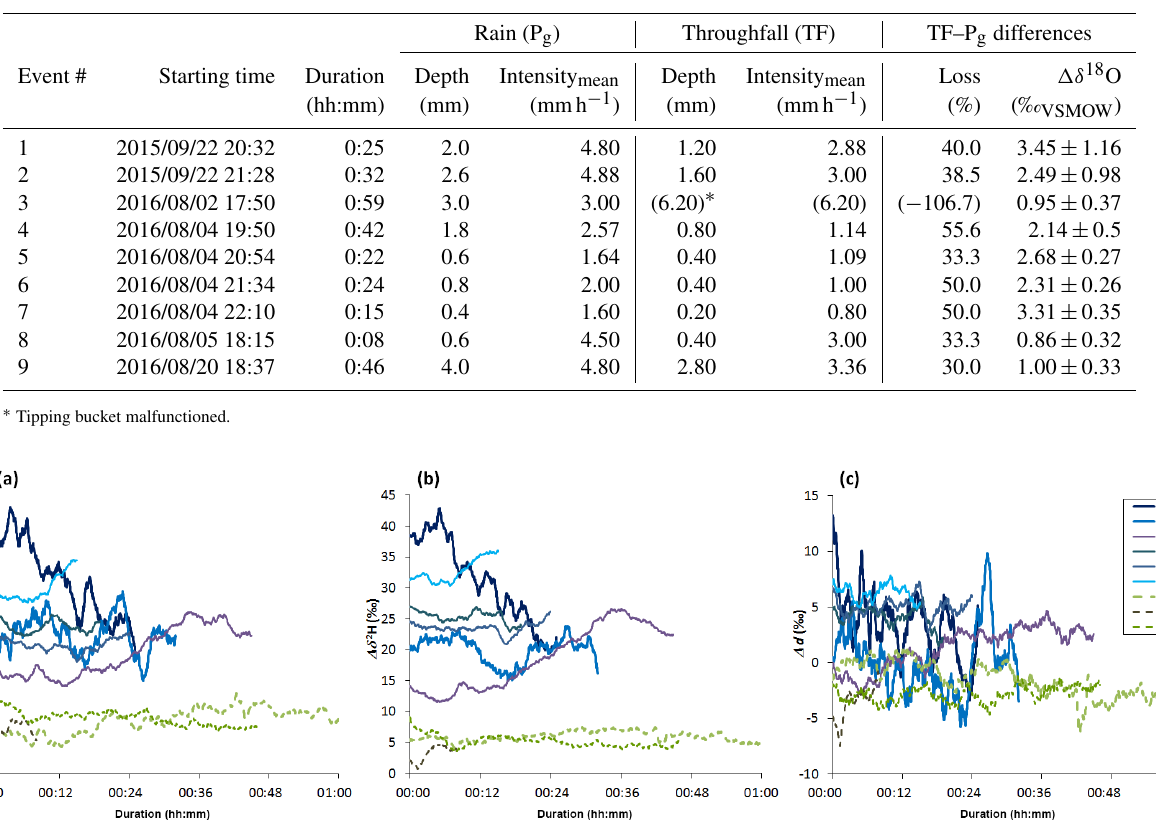
Figure 5. Time series of differences between the isotopic signature of TF and P g , (a) (cid:49)δ 18 O, (b) (cid:49)δ 2 H, and (c) (cid:49)d ; events on initially dry canopy (dashed line) and on wet canopy (solid